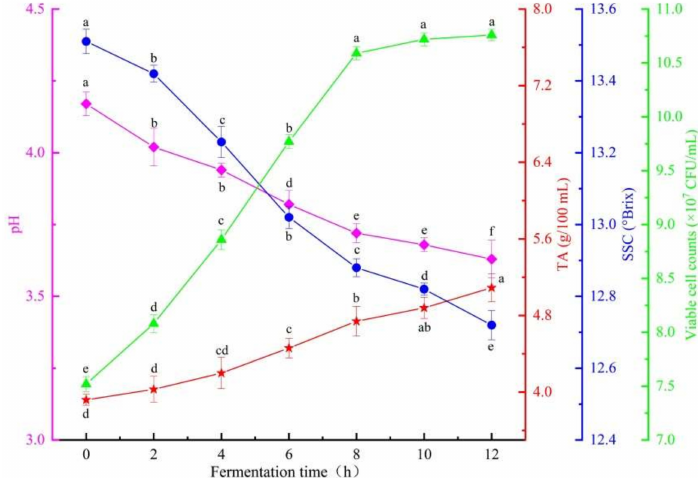
Figure 1. Physicochemical and microbiological chemical indicators of apricot juice of different fermentation stages. pH, titratable acid (TA), soluble solids content (SSC), viable cell counts. Different lowercase letters indicate significant differences between samples at different fermentation stages ( p <